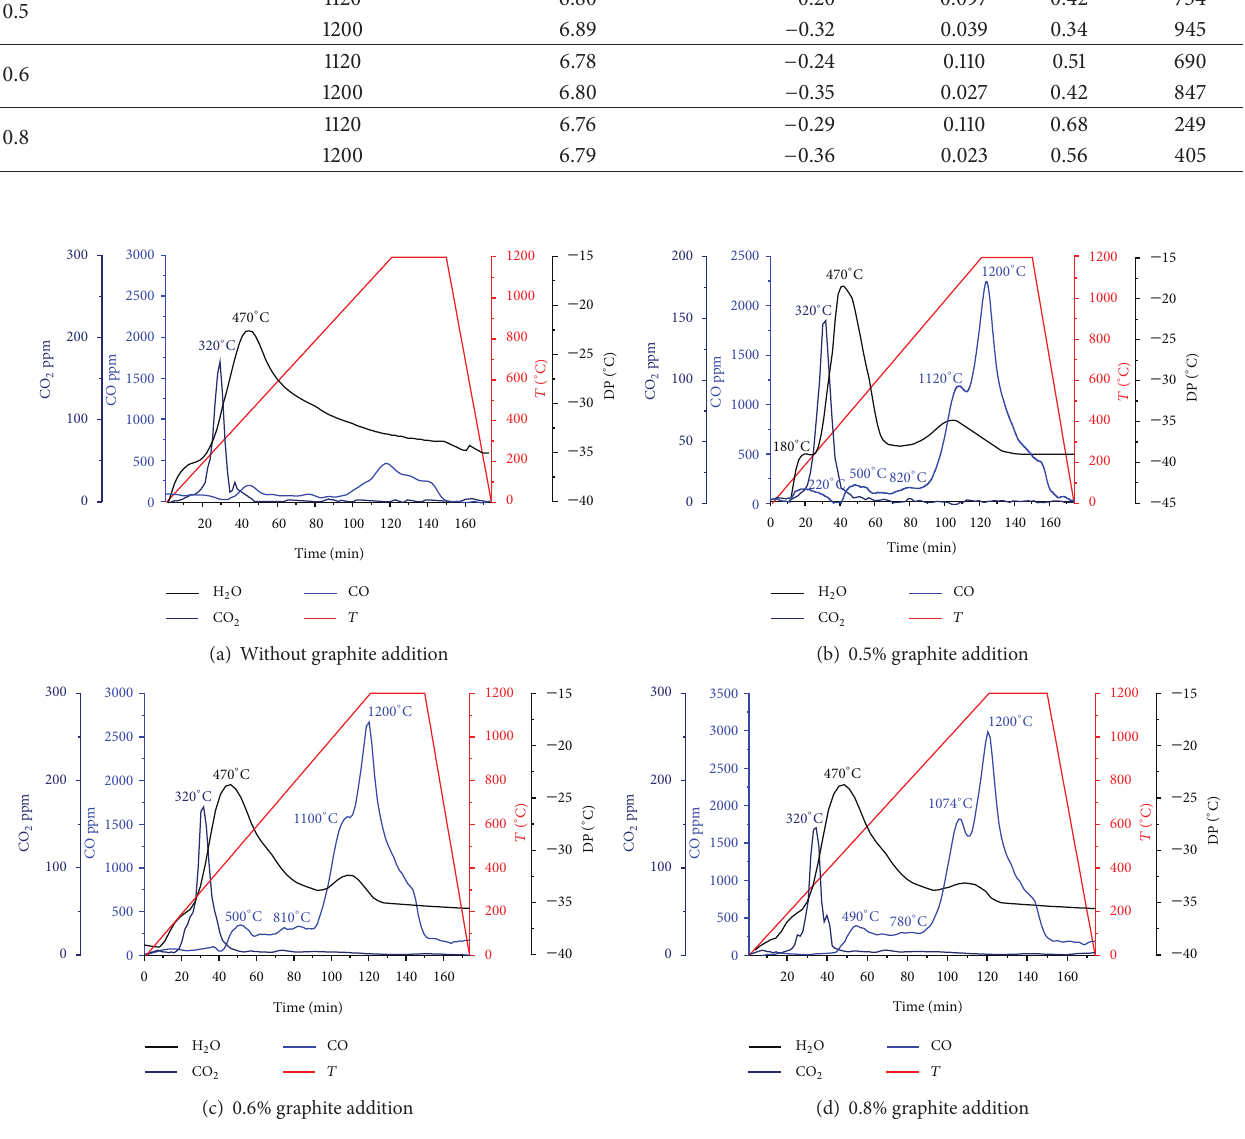
Figure 13: (a)–(d) Spectra of sampled processing gas composition during sintering of AstCrM components without carbon and with 0.5, 0.6, and 0.8wt.% graphite addition at 1200 ∘ C for 30min in 10% H 2 -N 2